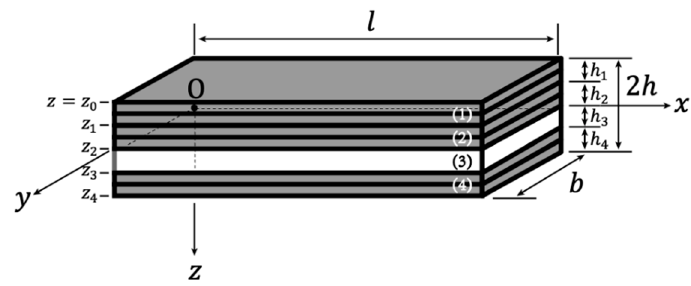
Figure 4. Schematic of the structure of KNN/EP with CFRP electrodes.